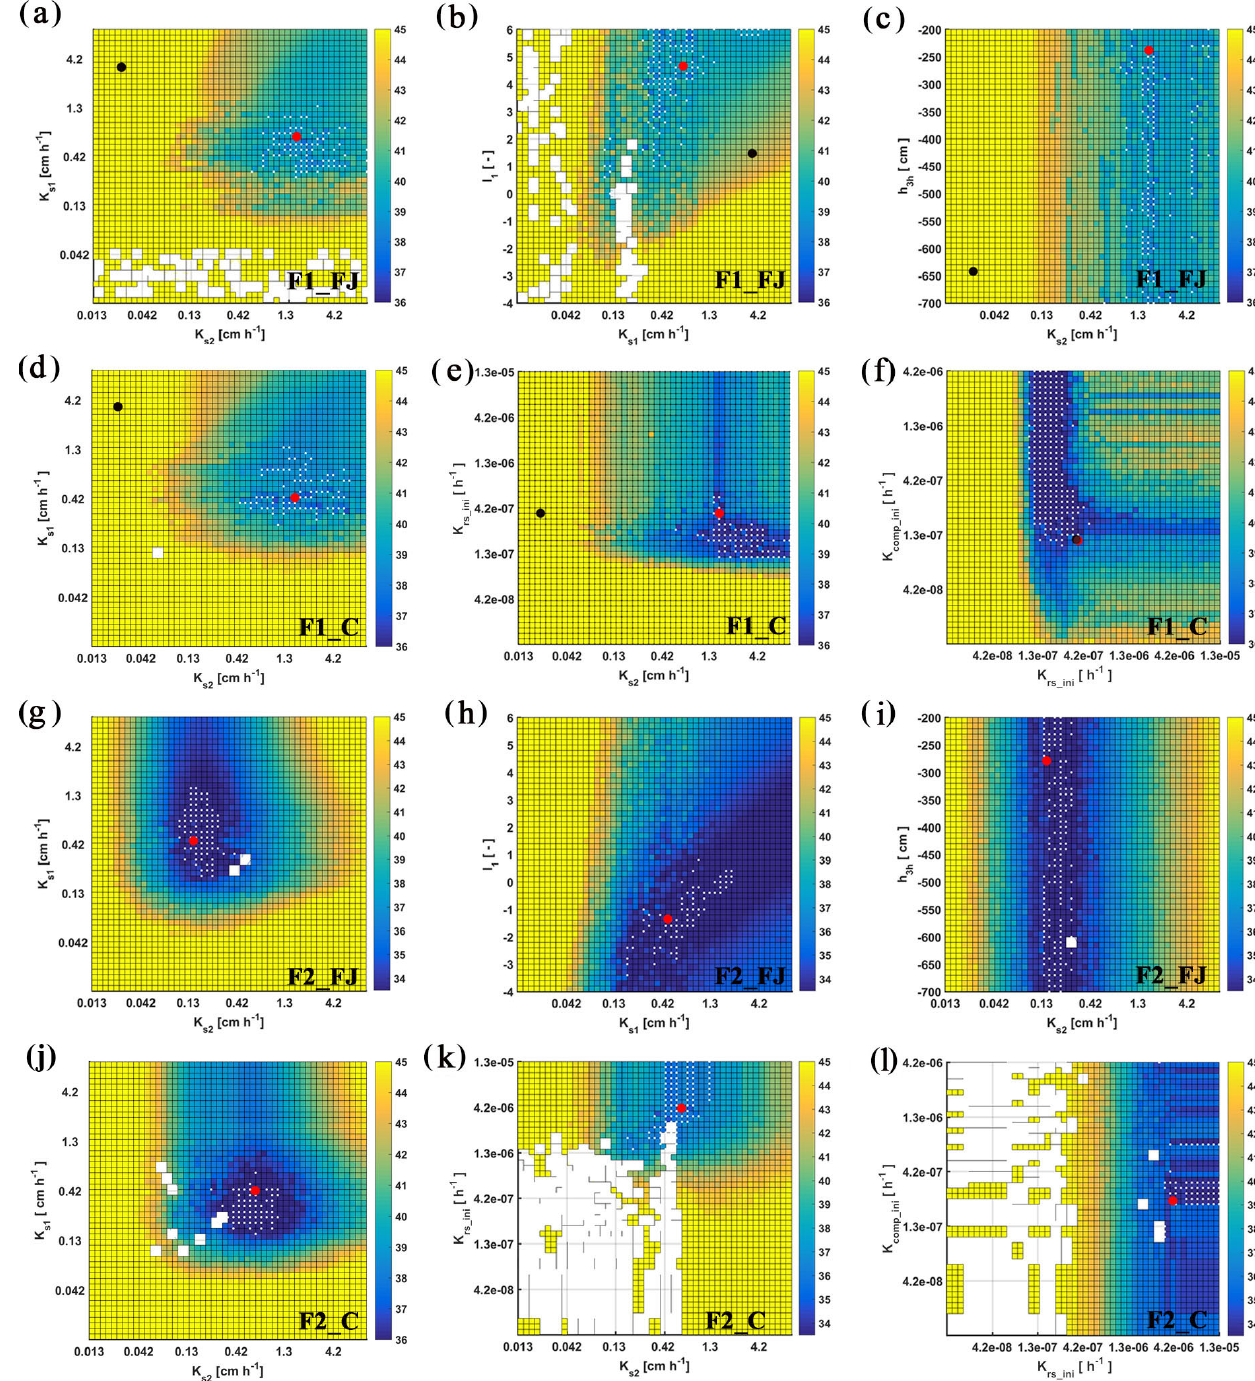
Figure 8. Response surface for K s2 – K s1 (FJ, Feddes–Jarvis model), K sl – l 1 (FJ), K s2 – h 3h (FJ), K s2 – K s1 (C, Couvreur model), K s2 – K rs_ini (C), and K rs_ini – K comp_ini (C) parameter planes of the stony (F1) and silty (F2) soils. The color bar shows the range of the objective function. White dot: area within 0.5% range of objective function (OF) minimum; red dot: optimum value obtained from the inverse modeling; black dot: optimum value obtained from the sheltered plot of the stony soil. K s : saturated conductivity; l : empirical model parameter; 1 and 2: top- and subsoil; K rs : root system conductance; K comp : compensatory root water uptake (RWU) conductance; h 3h : water potential at high